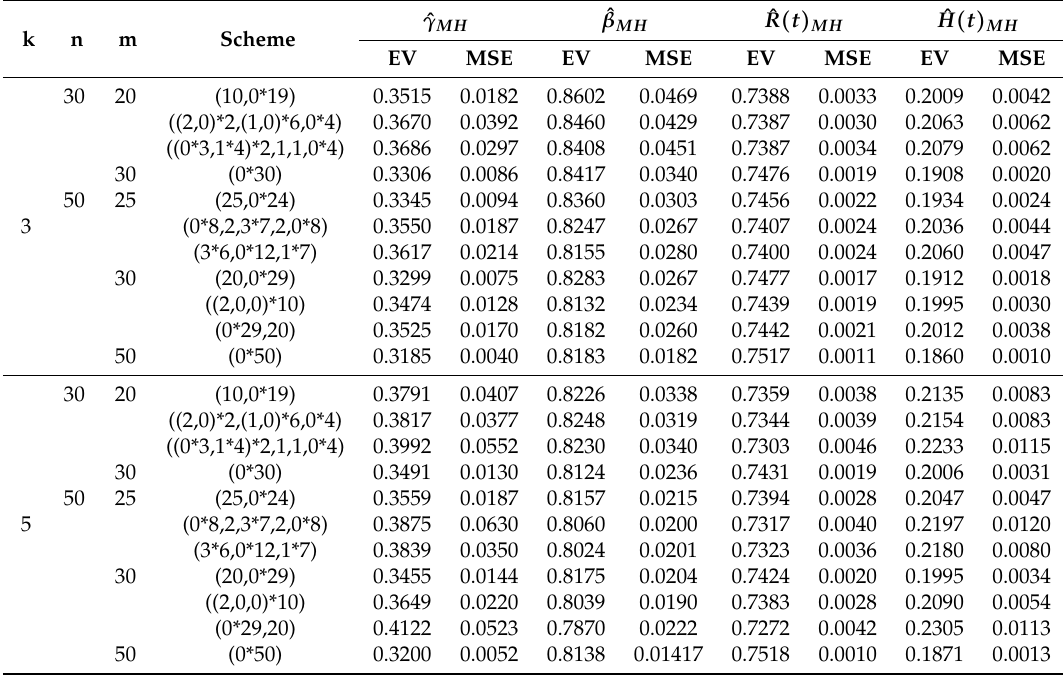
Table 11. Estimation values and MSEs of parameters, reliability and hazard functions using Metropolis-Hastings method and noninformative priors under SELF when γ = 0.3, β = 0.8, t =